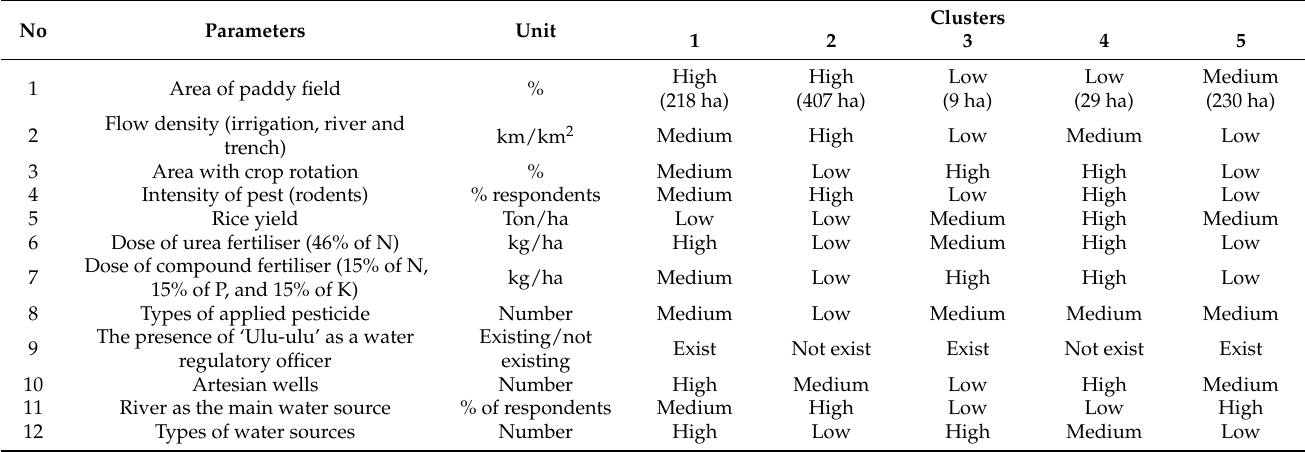
Table 6. The result of cluster analysis and characteristic results for the 12 parameters.